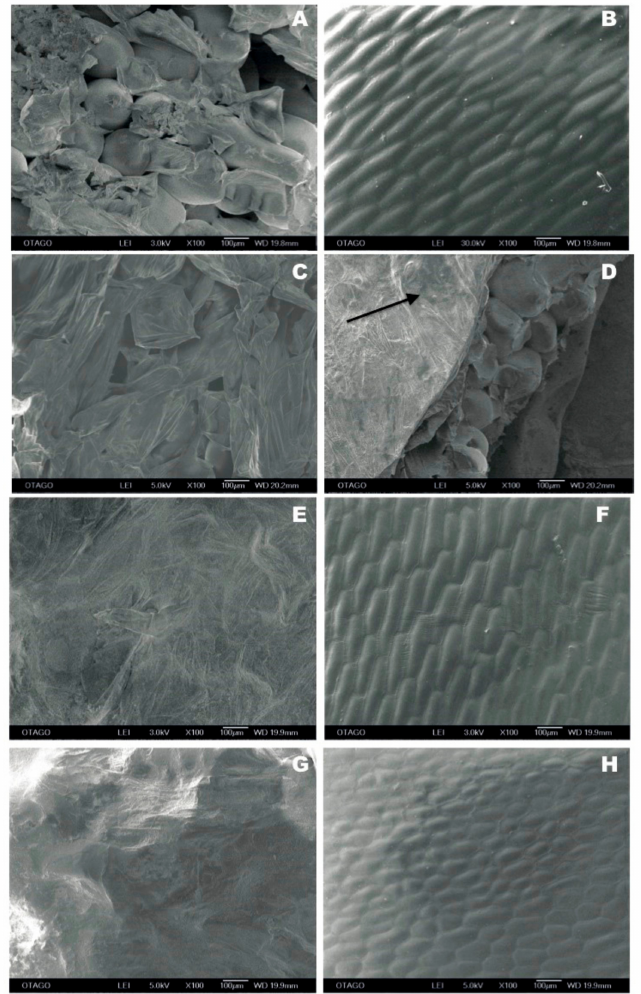
Figure 4. Cryogenic scanning electron micrographs of onion tissues observed (magnified view of 100 × ) at the abaxial (outer) and adaxial (inner) surfaces of the fleshy scales from untreated and PEF-treated onion bulbs. ( A ) The adaxial surface of scale 2 from an untreated onion. ( B ) The abaxial surface of scale 2 from an untreated onion. ( C ) The adaxial surface of scale 3 from an “NFE-PEF3” onion. ( D ) The adaxial surface of scale 3 from an untreated onion. ( E ) The adaxial surface of scale 2 from an “FE-PEF3” onion. ( F ) The abaxial surface of scale 2 from an “FE-PEF3” onion. ( G ) The adaxial surface of scale 3 from an “FE-PEF2” onion. ( H ) The abaxial surface of scale 3 from an “FE-PEF2”